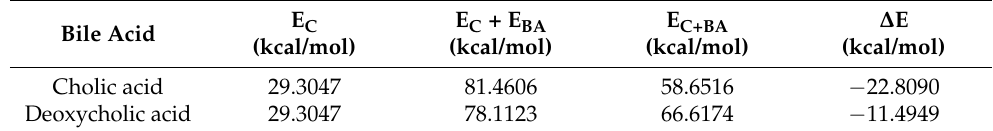
Table 4. The minimized total energies of clindamycin hydrochloride (E C ), bile acids (E BA ) and clindamycin-bile acid complexes (E C+BA ).